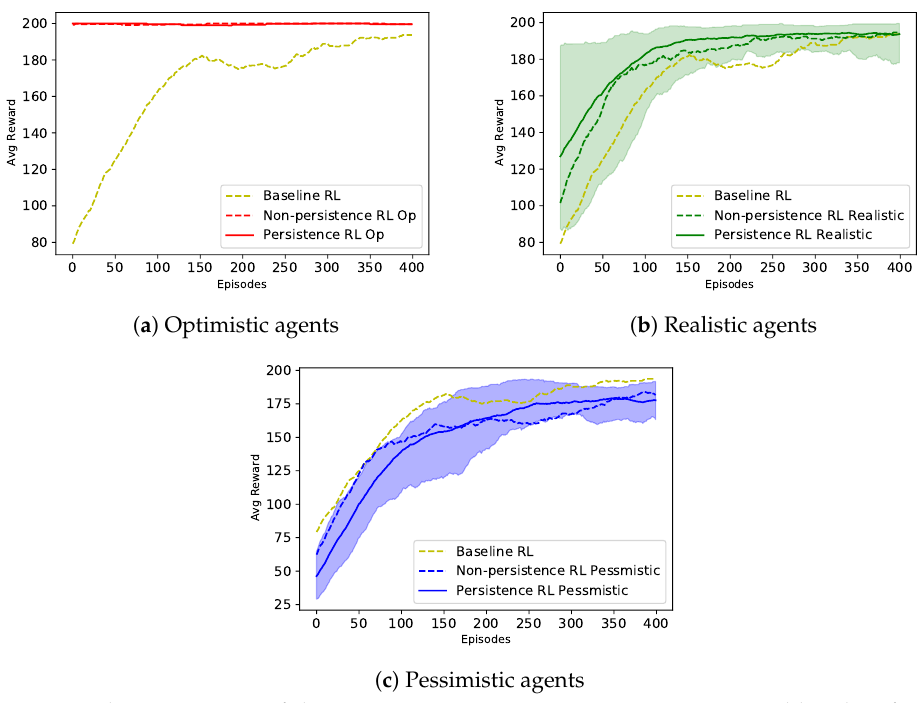
Figure 8. The comparison of the persistent agents, non-persistent agents, and baseline for each kind of agent in deep reinforcement learning built with the cart pole environment. The shaded area indicates the deviation between the minimum and maximum values of the agent value after multiple training times.